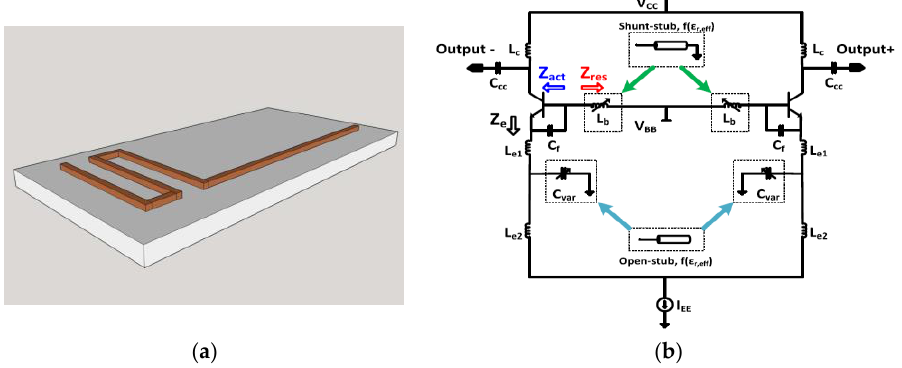
Figure 12. ( a ) Transmission line used as the sensor in the configuration of open or shunt stub; ( b ) Colpitt’s oscillator in which the sensor is embedded [59].